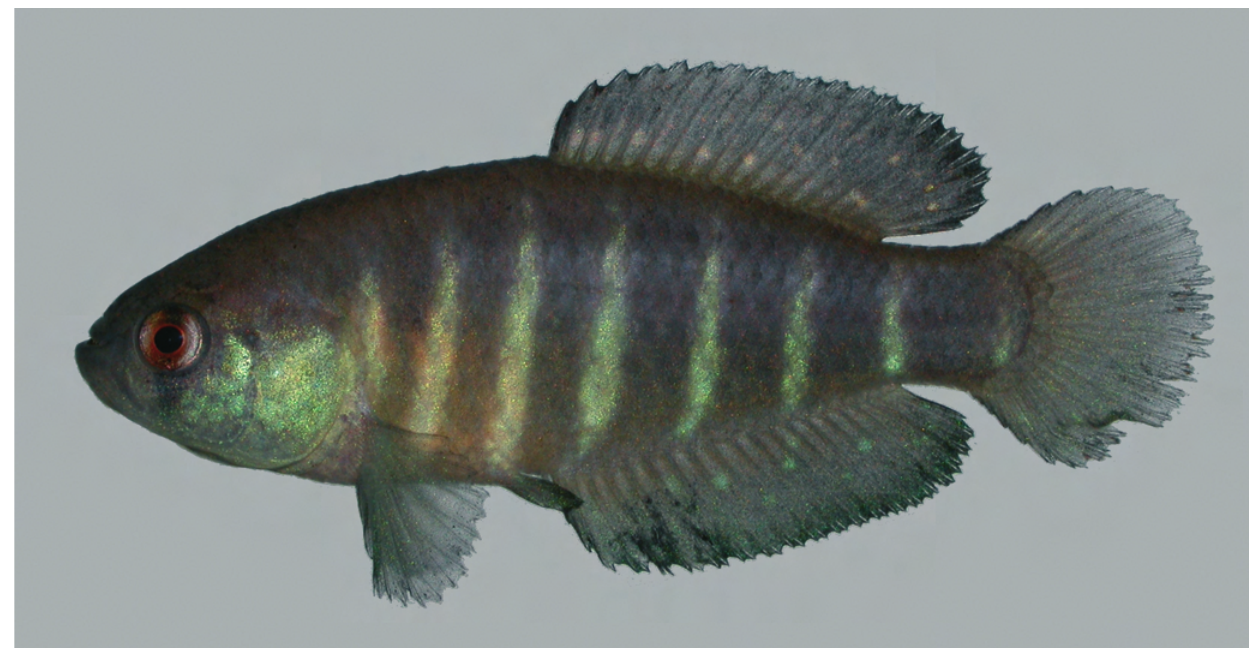
Fig. 1. Austrolebias paucisquama , holotype, MCP 41879, male, 34.2 mm SL, Rio Grande do Sul, São Sepé, temporary pool